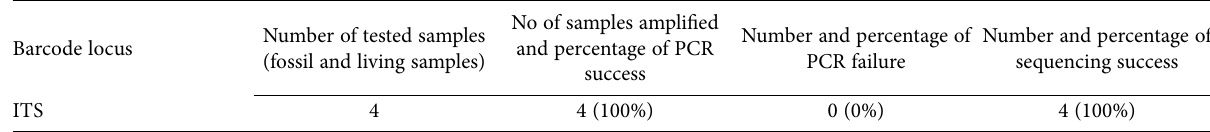
Table 4. Success rates of the amplification and sequencing.